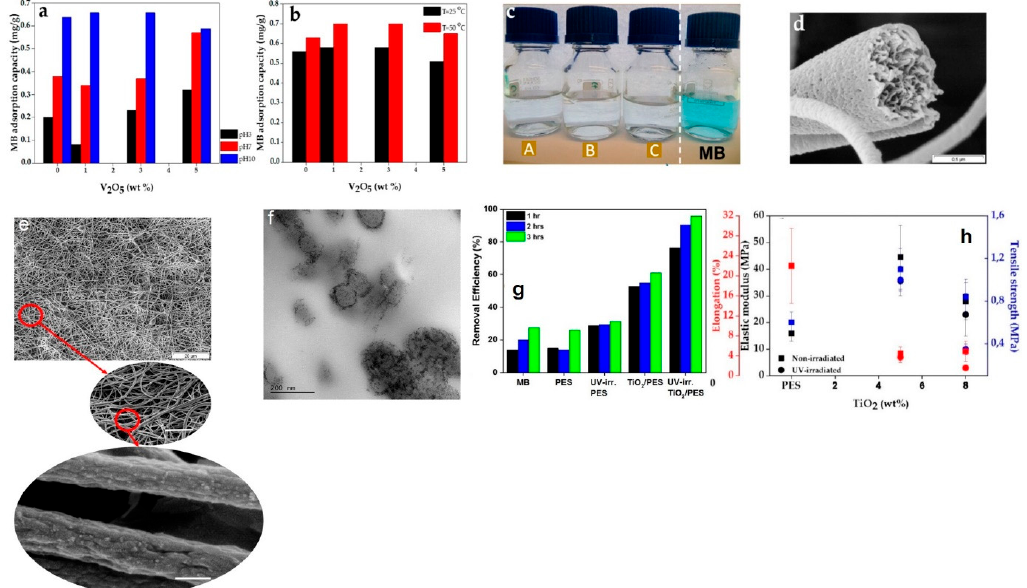
Figure 9. MB adsorption capacity for the V 2 O 5 /PES nanofibers with different nanofiller contents depending on ( a ) pH and ( b ) temperature (at pH 10). ( c ) The digital image shows the aqueous solutions decolorized by the V 2 O 5 / PES nanofiber adsorbents under a high temperature and pH compared to the untreated MB solution (A–C: exposed to PES, 1 wt.% V 2 O 5 / PES and 5 wt.% V 2 O 5 / PES nanofibers, respectively). ( d ) The SEM image witnesses the porosity available in the cross-section as well as on the surface of the V 2 O 5 / PES nanofibers (5 wt.%). Reproduced with permission [6]. Copyright 2016,